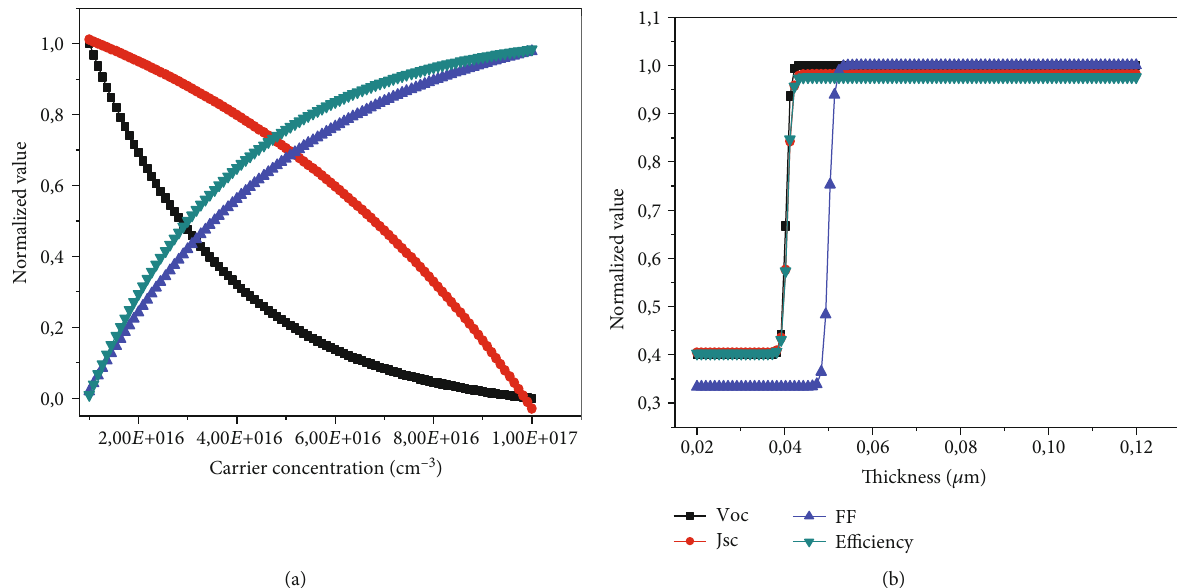
Figure 4: Calculated normalized output parameters of CFTS solar cell as a function (a) of carrier concentration and (b) of the thickness in the CdS bu ff er layer.